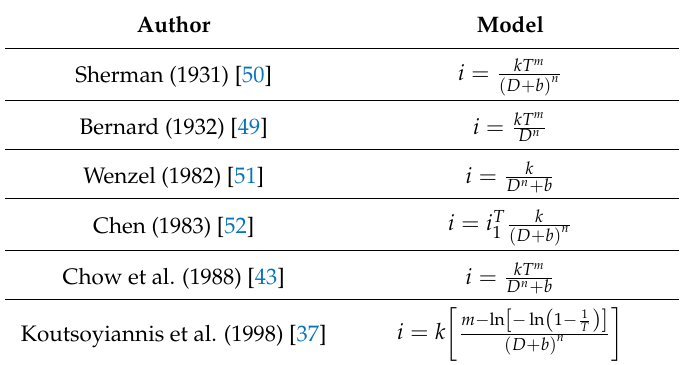
Table 2. Mathematical models for IDF curve estimation available in WEBSE